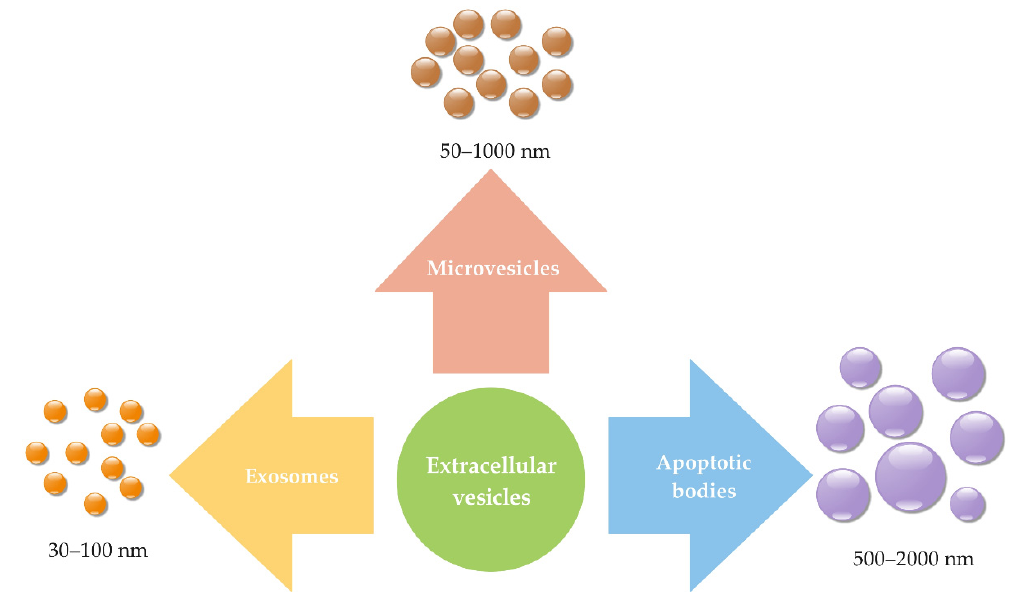
Figure 1. Classification of extracellular vesicles according to their size into exosomes (size diameter around 30–100 nm), microvesicles (size diameter around 50–1000 nm), and apoptotic bodies (size diameter around 500–2000 nm; summarized from [14,16,25,26]).